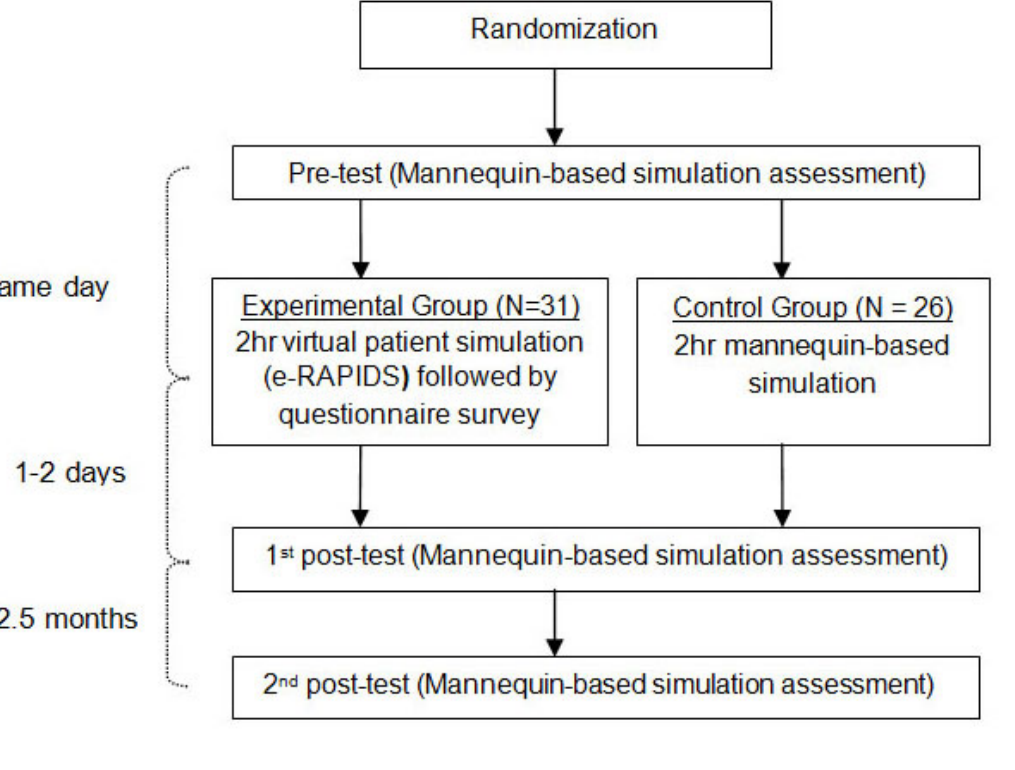
Figure 3. Flow of data